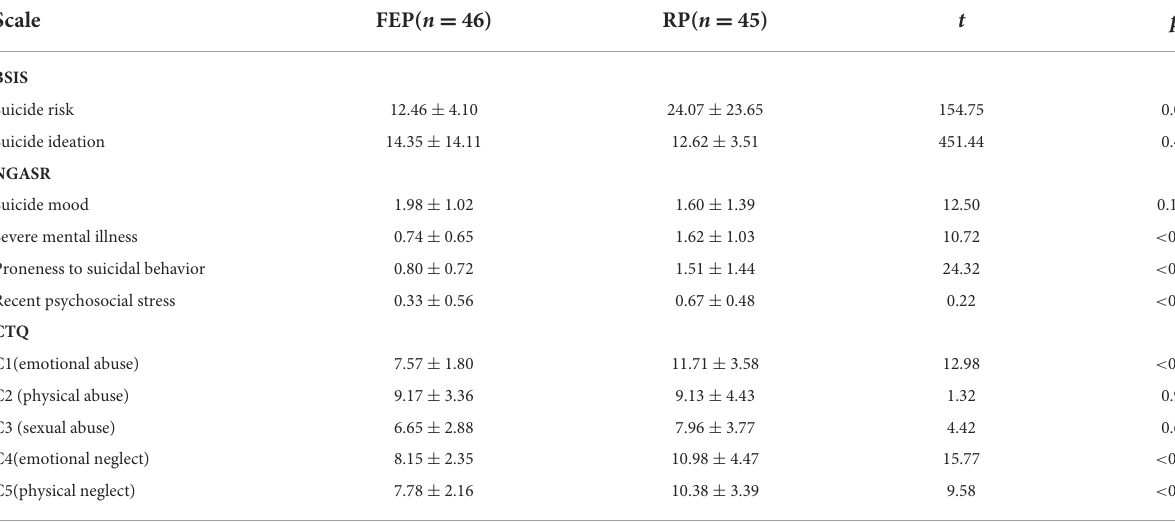
TABLE 2 Comparisons in CTQ, suicidal symptoms and psychotic